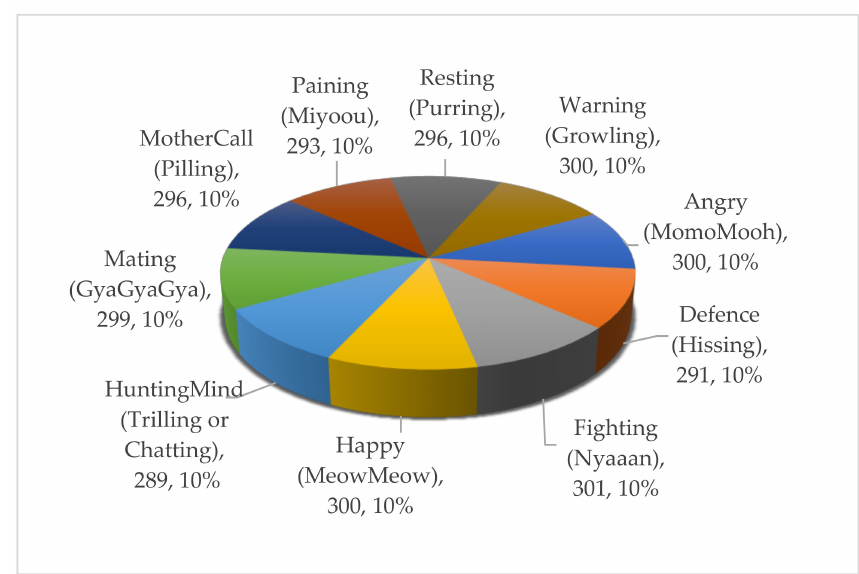
Figure 1. Balanced cat sound dataset representation. Each class in the dataset is named according to the mood or the situation of the cat when they are making sound. The onomatopoeia words in parentheses are the imitation of the cat sounds in each class. The numbers indicate the number of cat sounds and the numbers with percent is the corresponding portion of each class size in the dataset.